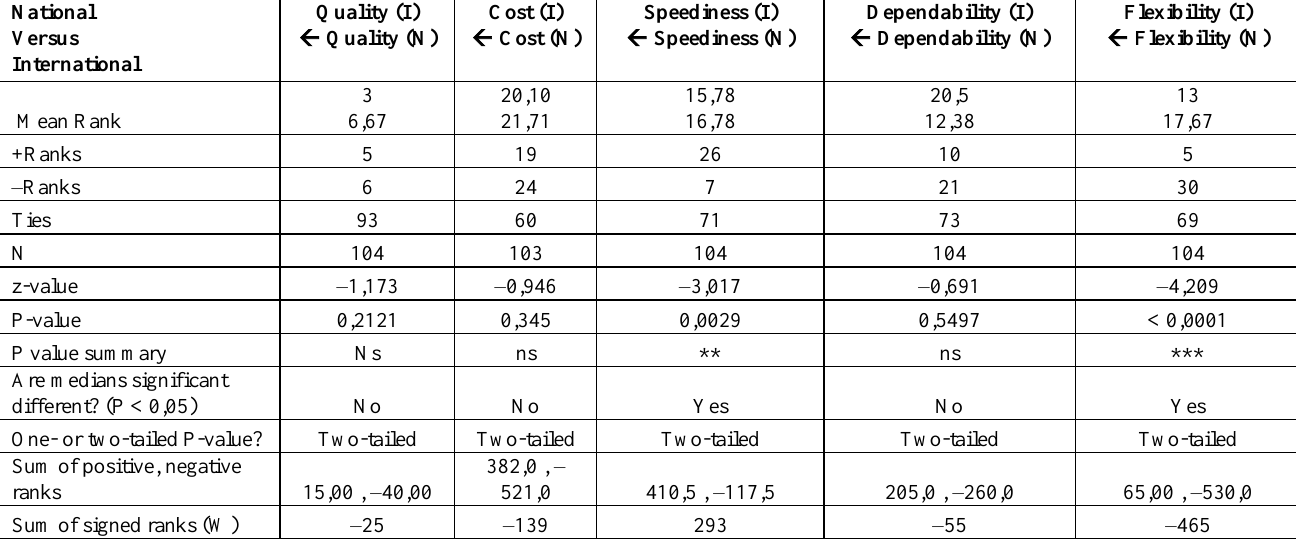
Table 8 Wilcoxon matched-pairs signed ranks rests: movement between decision points : Future